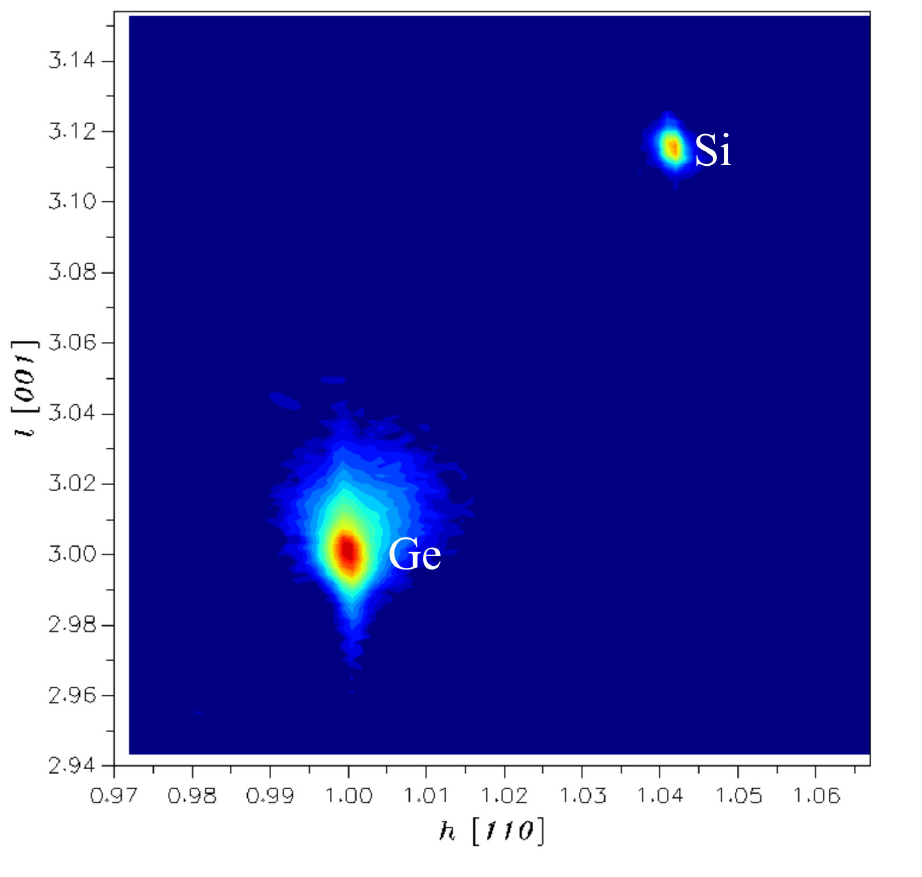
Figure 16. High–resolution reciprocal lattice maps (HRRLMs) around Si and Ge (113) diffraction of the optimized process of 1.4 µ m–thick Ge